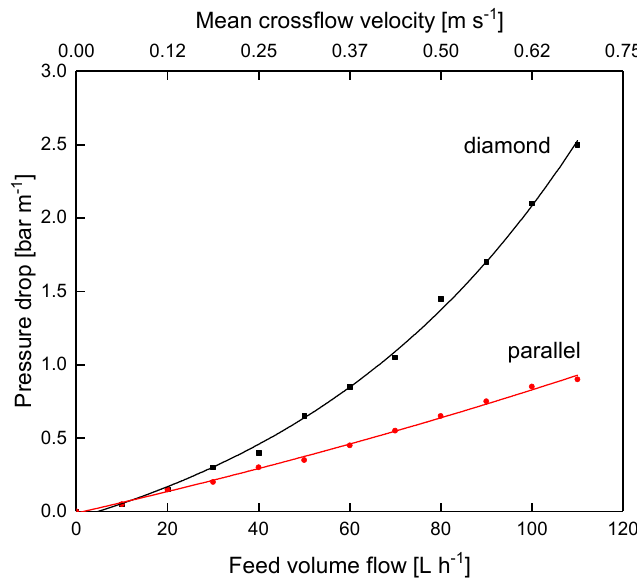
Figure 9. Pressure drop of the parallel and the diamond spacer as a function of the feed volume flow of water at 10 °C without permeate production. The graph shows data obtained from a single experiment.